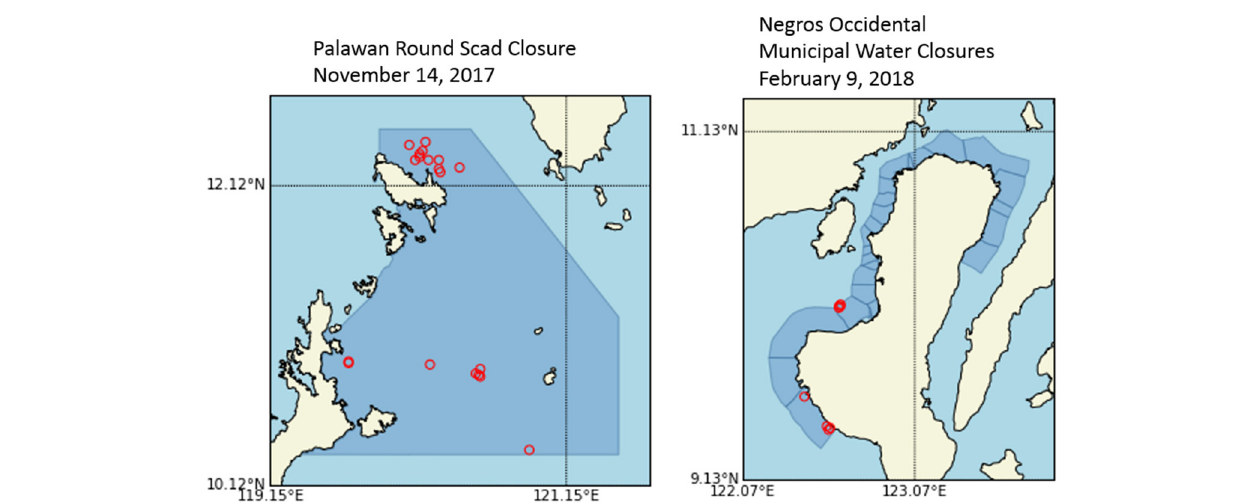
FIGURE 11 | Examples of the graphical maps that accompany the VBD detection alerts for fishery closures. In the Palawan closure there is a cluster of detections north of Busuanga Island, an area known for frequent encroachment. In Negros Occidental there is a cluster of detection in the outer zone of the Ilog municipal water closure. The alerts are used by BFAR and provincial enforcement teams to plan enforcement